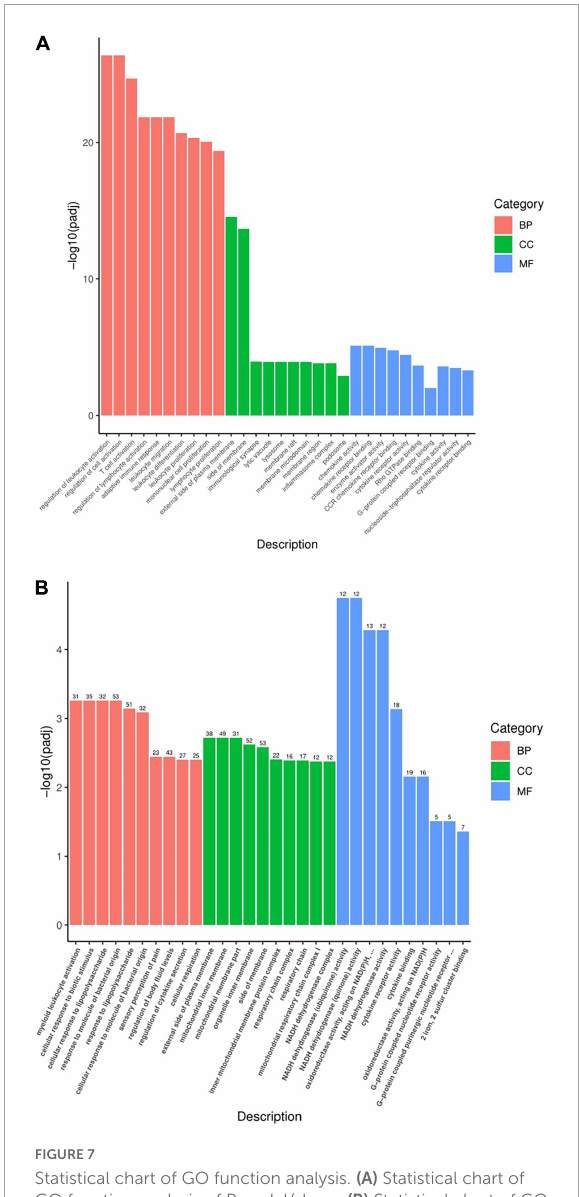
FIGURE7 Statistical chart of GO function analysis. (A) Statistical chart of GO function analysis of Pmodel/sham. (B) Statistical chart of GO function of Pmodel/EA. The X -axis represents the secondary classification term of GO, and the Y -axis represents the percentage of genes included in the secondary classification. Three colors represent three categories: Red refers to BP (biological process), green refers to CC (cell composition), and blue refers to MF (molecular function).